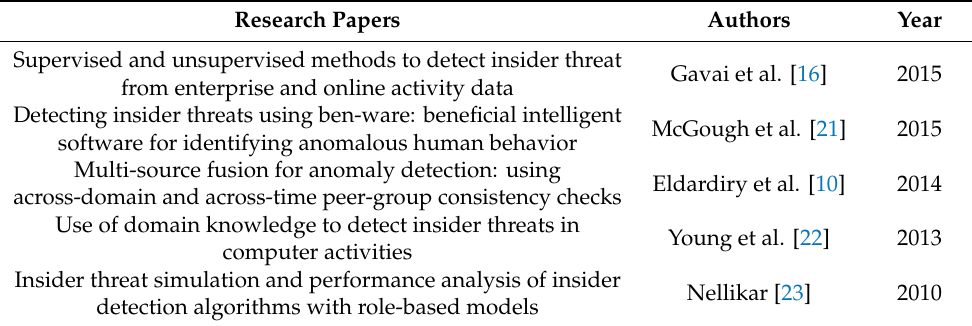
Table 2. Referred articles for variable selection.